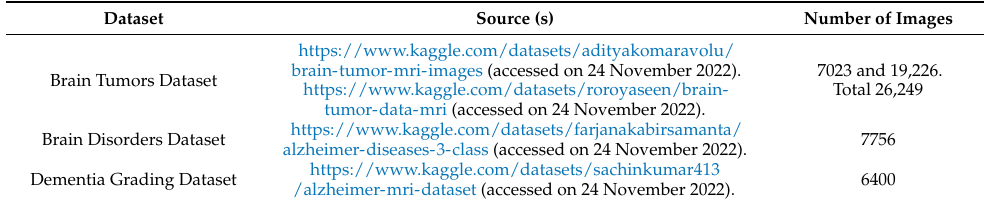
Table 1. Study’s datasets